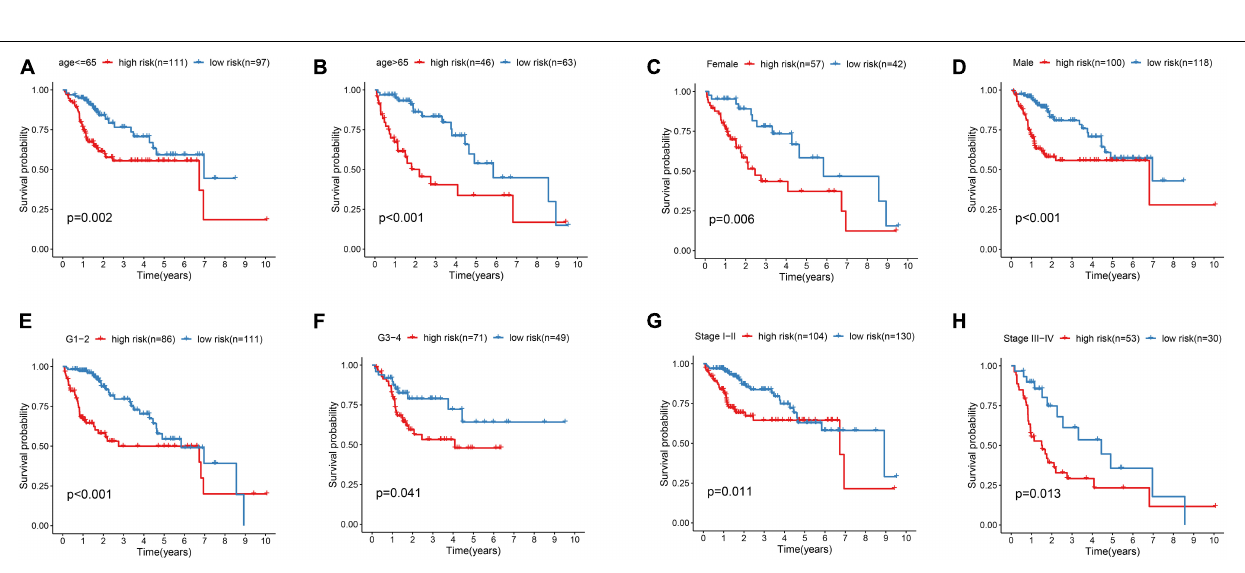
FIGURE 6 | Kaplan-Meier survival curves for the high- and low-risk groups stratified by clinical factors. (A,B) Age. (C,D) Gender. (E,F) Grade. (G,H) Stage.